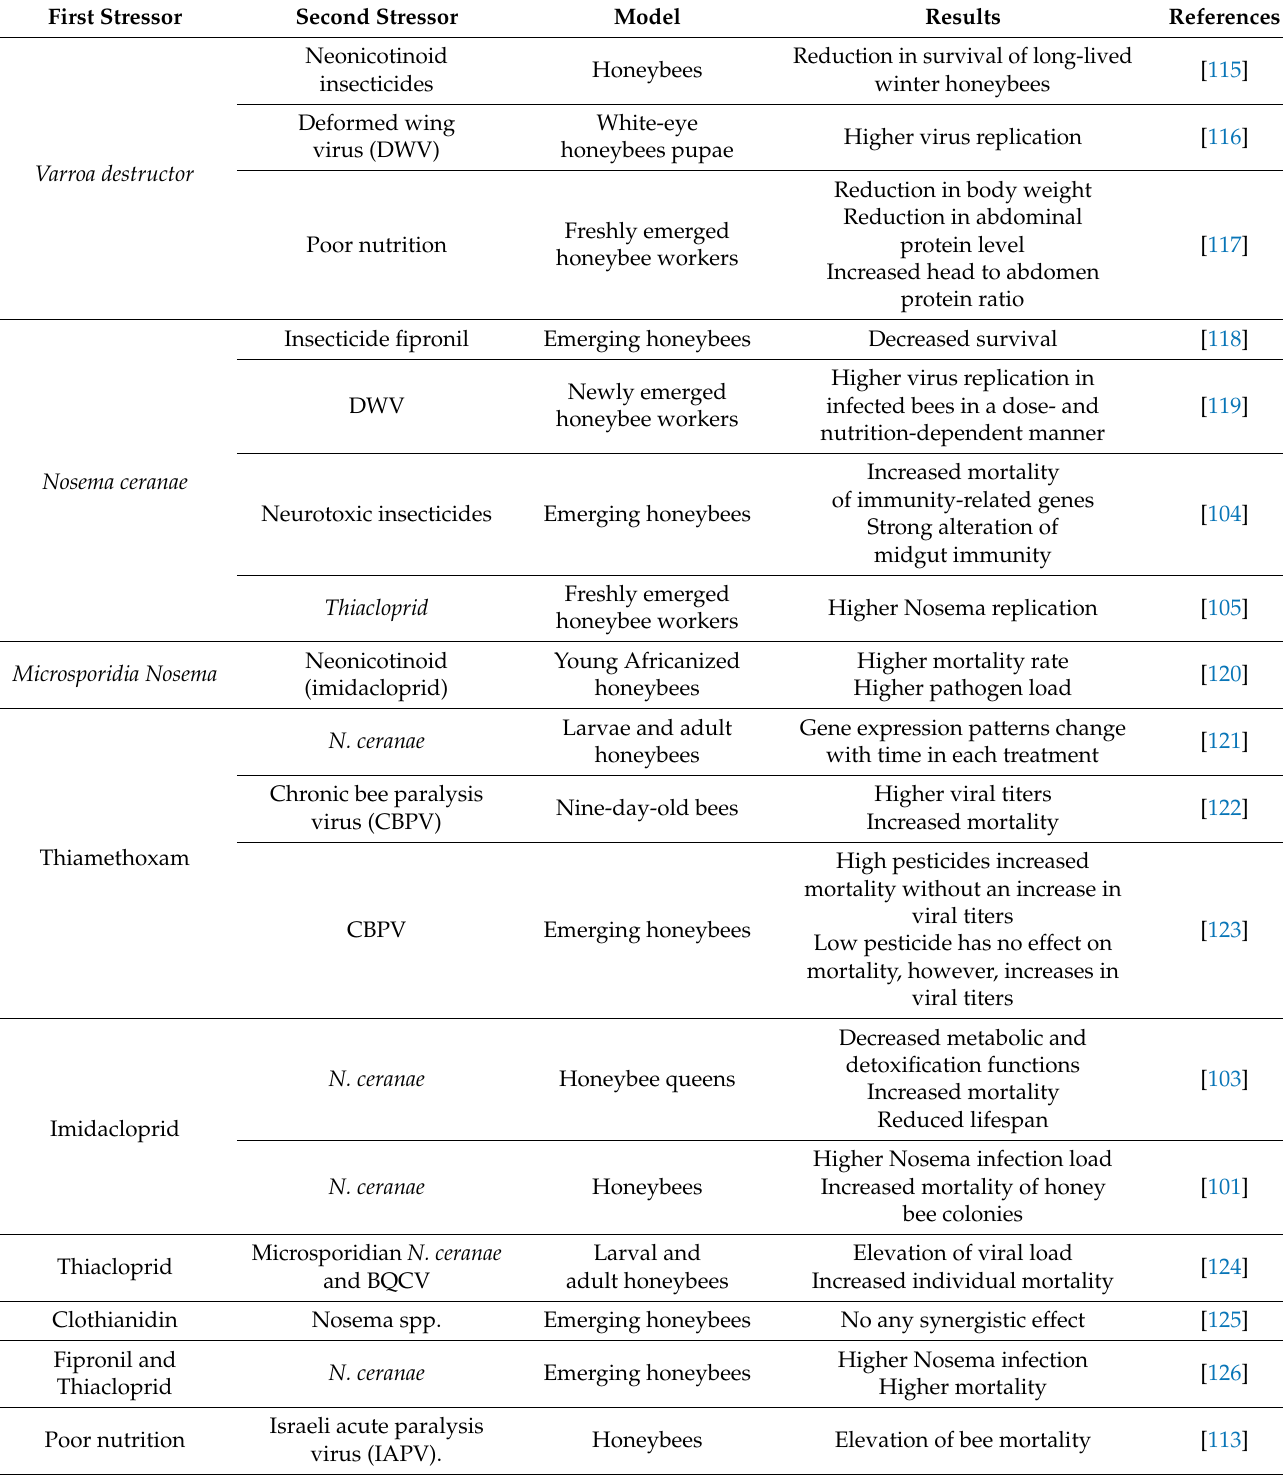
Table 1. Summary of laboratory studies discussing the interaction between stressors on honeybees ( Apis mellifera